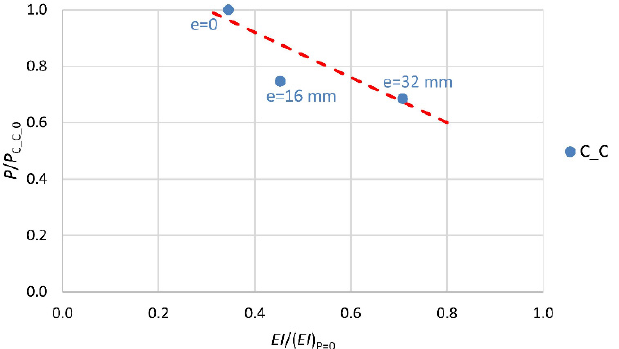
Figure 8. Change in stiffness of reference specimens depending on intensity of their stress.